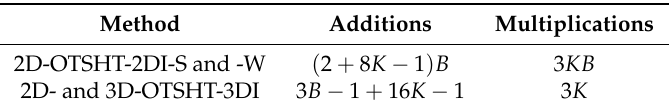
Table 2. The number of additions and multiplications per pixel for searching patches having B bands with K basis